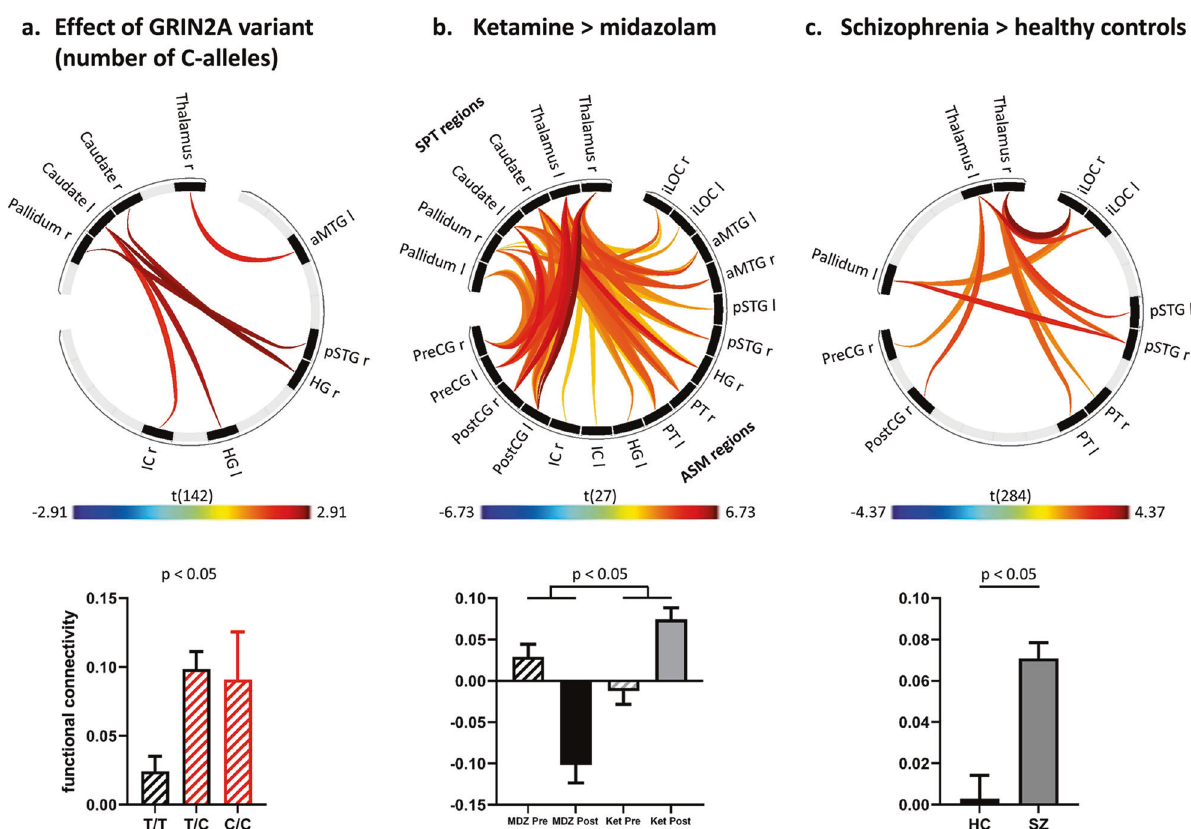
Fig. 4 Striato-pallido-thalamo-cortical hyper-connectivity. Functional network connectivity analysis assessing the impact of the genetic variant ( a ), the differential effect of ketamine versus midazolam ( b ) or schizophrenia versus controls ( c ) on the overall connectivity between a striato-pallido-thalamic (SPT) and an auditory-sensory-motor (ASM) set of regions. A signi fi cant overall hyper-connectivity between the two sets of regions emerged for all three contrasts of interest. ROI-to-ROI connectivities that contributed most to the increase of overall network connectivity (as de fi ned by an uncorrected p -value of < 0.05) are depicted in connectivity rings (upper panels). Their respective means and standard errors for each group / condition are illustrated in bar plots (lower panels). iLOC inferior lateral occipital cortex, aMTG anterior middle temporal gyrus, pSTG posterior superior temporal gyrus; HG Heschl ’ s gyrus, PT planum temporale, IC insular cortex, PostCG postcentral gyrus, PreCG precentral gyrus, l left, r right, Ket ketamine, MDZ midazolam, HC healthy controls, SZ the different datasets and contrasts relating it both to schizo- phrenia and NMDAR dysfunction. Correlation between functional connectivity and language symptoms Whereas we could not detect signi fi cant connectivity changes fusiform cortex (aSTG r – TOFusC r) as well as between the left related to the genetic variant for the inferior frontal gyrus seed, for posterior superior temporal gyrus and – again- the right occipital the left posterior superior temporal gyrus, four clusters emerged fusiform cortex (pSTG l – TOFusC r). Connectivity estimates comprising the bilateral superior occipital cortex (sLOC), the right gradually decreased with growing numbers of C-alleles and temporo-occipital fusiform cortex (TOFusC r) and the left temporo- turned negative for the homozygous C/C-genotype (Fig. 5b). occipital inferior temporal gyrus (toITG l), respectively (Fig. 6). We We subsequently tested these two connectivities for the subsequently assessed the association of this connectivity with comparison of ketamine versus midazolam in the pharmaco- qualitative language symptoms, as this language domain was fMRI dataset and for the comparison of the whole schizophrenia most affected by the genetic variant. Indeed, it turned out that the sample versus the healthy control subjects. For the former language symptomatology correlated with the connectivity comparison (ketamine > midazolam), we observed signi fi cantly between the left superior temporal gyrus and the bilateral reduced connectivity between the right anterior superior temporal superior occipital cortex, i.e., the lower the connectivity estimate, gyrus and the right temporal occipital fusiform cortex (aSTG r – the higher the burden of language-related negative symptoma- TOFusC r), too, which was explained by the opposing effects of the tology (left superior occipital cortex: r = 0.183, p-FDR = 0.028, two drugs, i.e., a ketamine-induced decrease and a midazolam N = 145; right superior occipital cortex: r = 0.254; p-FDR = 0.004, induced increase of functional connectivity. For the latter N = 145). The two other connections which were affected by the comparison (schizophrenia > healthy controls) we could repro- genetic variant did not show a signi fi cant correlation with the duce reduced connectivity for both connections (aSTG r – TOFusC symptomatology (pSTG l – TOFusC r: r = 0.038; p = 0.325; pSTG l – r and pSTG l – TOFusC r) in the patients. Accordingly, hypo- toITG l: r = 0.097; p = 0.168). We subsequently tested the connectivity between the superior temporal gyrus and inferior connections of the left posterior superior temporal gyrus with temporo-occipital regions emerged as a consistent fi nding across